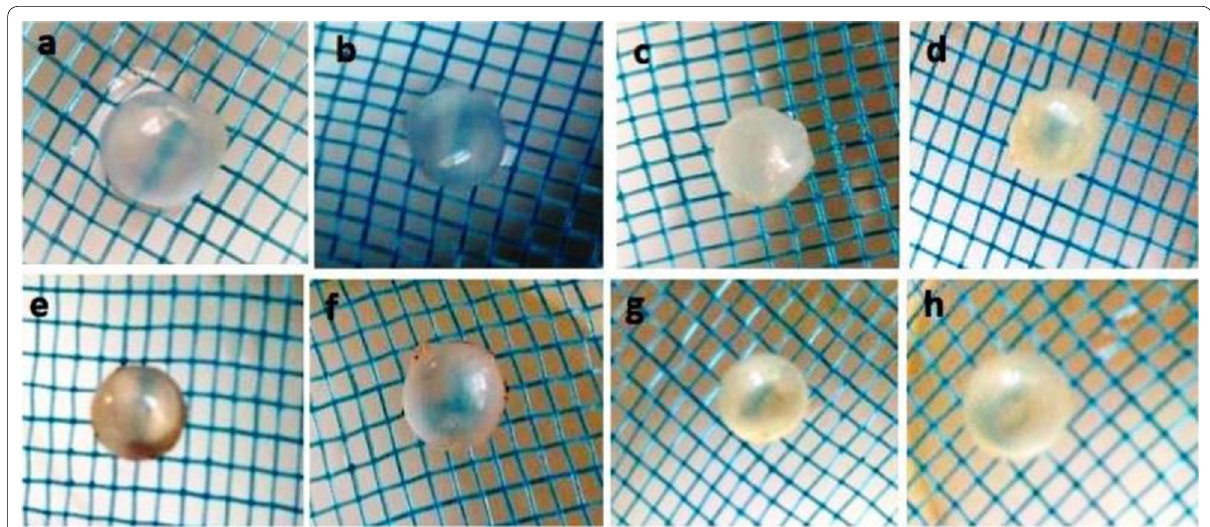
Fig. 1 Effect of P. erinaceus and A. spinosus on lens opacity. a induction of cataract (72 h after). b bw 55 mM glucose; e and f + kg bw 55 mM glucose +